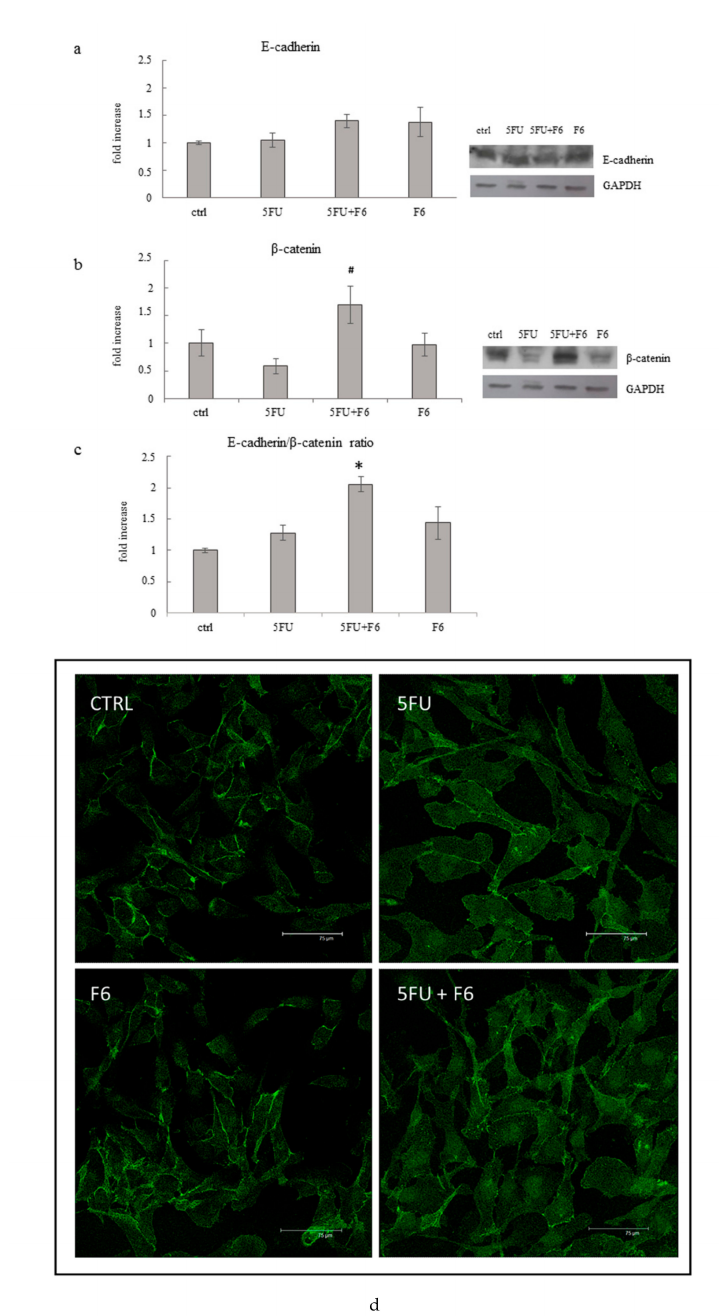
Figure 8. E ff ect of 5FU, 5FU + F6, and F6 on expression of E-cadherin ( a ), β -catenin ( b ), and E-cadherin / β -catenin ratio ( c ) in MDA-MB-231 cells. Columns represent densitometric quantification of optical density (OD) of specific protein signal normalized with the OD values of GAPDH served as a loading control and they are expressed as fold increase of control value considered as 1. Each column represents the mean value ± SD of three independent experiments. * p < 0.05 versus ctrl; # p < 0.05 versus 5FU by ANOVA followed by Bonferroni post-test. Representative western blot analysis relating to E-cadherin and β -catenin expression in MDA-MB-231 cells untreated (ctrl) and treated with 5FU, 5FU + F6, and F6 for 24 h. GAPDH was used as loading control. ( d ) Confocal microscopy analysis of beta-catenin immunostaining (FITC / green signal) on MDA cells cultured in control condition, or with the following treatments: 5FU, F6, 5FU + F6. Distribution of β -catenin increase behind the cell membrane mostly in F6-treated